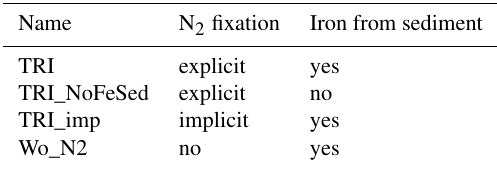
Table 1. Models parameters for Trichodesmium (Tricho.) and nanophytoplakton (Nano.). Parameters Symbol Units Value Reference Maximum growth rate for Tricho. µ Tri max d − 1 0.25 Breitbarth et al. (2007) Maximum growth rate for Nano. µ Nano max d − 1 1.0 Initial slope P-I Tricho. α I (Wm − 2 ) − 1 d − 1 0.072 Breitbarth et al. (2008) and Hood et al. (2001) Initial slope P-I Nano. α I (Wm − 2 ) − 1 d − 1 2.0 Microzoo preference for Tricho. p I – 0.5 Tri Microzoo preference for Nano. p I – 1.0 Nano Maximum Fe / C in Tricho. θ Fe molFe(molC) − 1 1 × 10 − 4 Kustka et al. (2003) max , Tri Maximum Fe / C in Tricho. θ Fe molFe(molC) − 1 4 × 10 − 5 max , Nano Maintenance iron m molFe(molC) − 1 Kustka et al. (2003) Maintenance use efficiency Kustka et al. (2003)